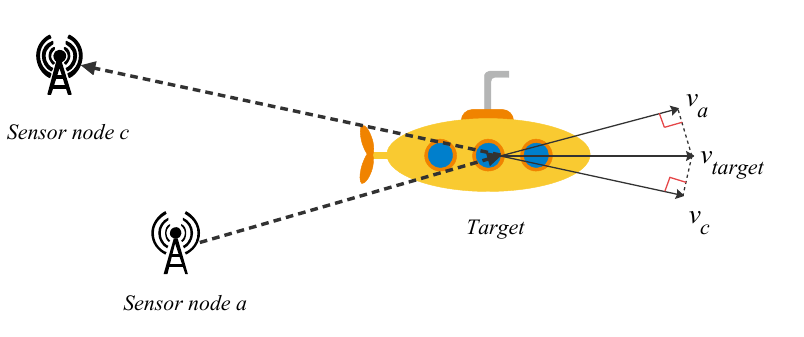
Figure 1. Network structure